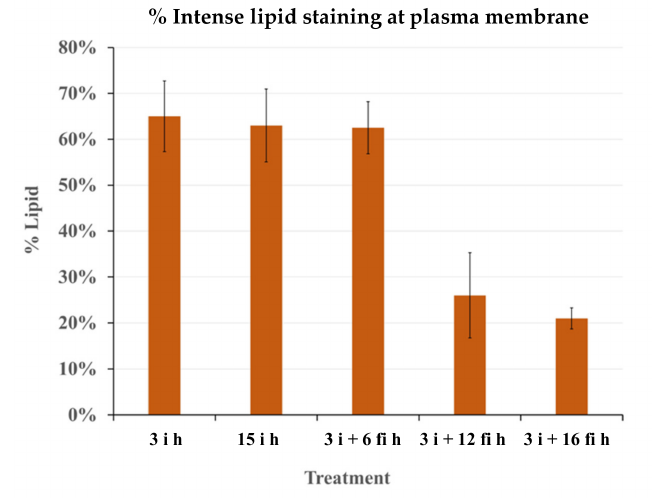
Figure 6. Percentage of the intensely Nile red stained portion of the plasma membrane. Average of five radicle cortical cells in each sample. Bars represent the standard deviation (SD).